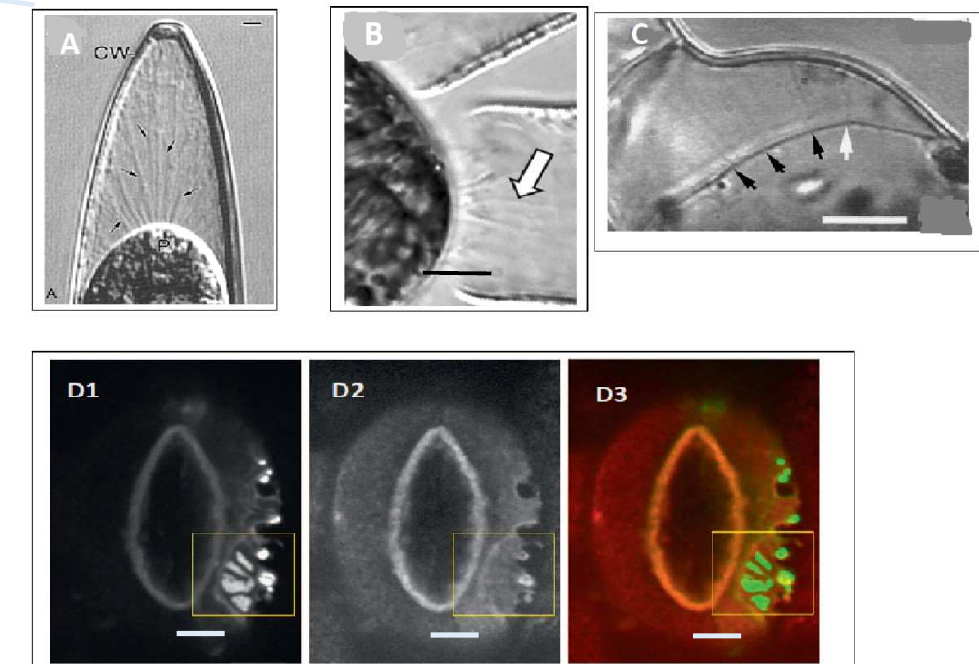
Figure 1. Hechtian strand occurrence: from algae to chloroplast guard cells. ( A ) Closterium desmid in 12% sucrose: reprinted from [22], Scale bar = 2.1 µm; ( B ) Penium margaritaceum : reprinted from [23], Scale bar = 2 µm; ( C ). Ginkgo cells plasmolysed in 0.3 M NaCl reprinted from [24], Scale bar is 10 µm; Arrows in ( A – C ) show location of Hechtian strands. ( D1–3 ) Guard cell H + -ATPase and its translocator PATROL (proton ATPase translocation control) in Arabidopsis . The plasma membrane ATPase AHA1 and its translocator PATROL1 co-localise at the tips of Hechtian strands in plasmolyzed guard cells transformed with GFP-PATROL1 ( D1 ) and RFP–AHA1 ( D2 ) merged in ( D3 ). Enlarged images of the region enclosed in the yellow square are not shown here. Reprinted from [25], Scale bars = 5 µm.